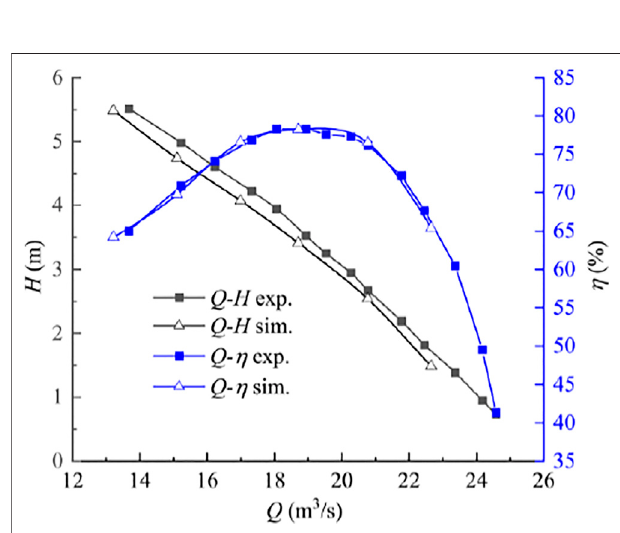
FIGURE 5 | Comparison of the head and ef fi ciency under different fl ow conditions.